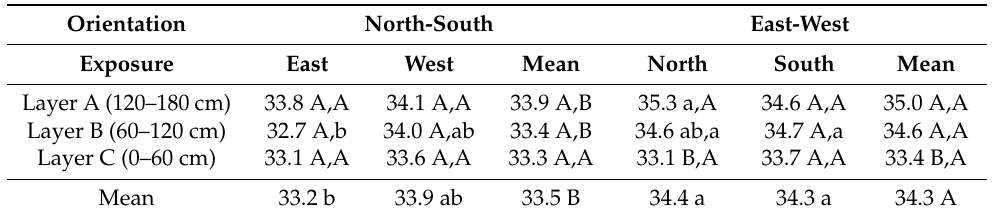
Table 11. Mean hulled almond polar gauge (PG, mm). The first letters denote significant differences between layers for a given exposure; the second letters denote significant differences between exposures for a given layer (SNK test). Lower case letters denote statistical differences with p = 0.05. Capital letters denote statistical differences with p = 0.01. Orientation North-South East-West Exposure East